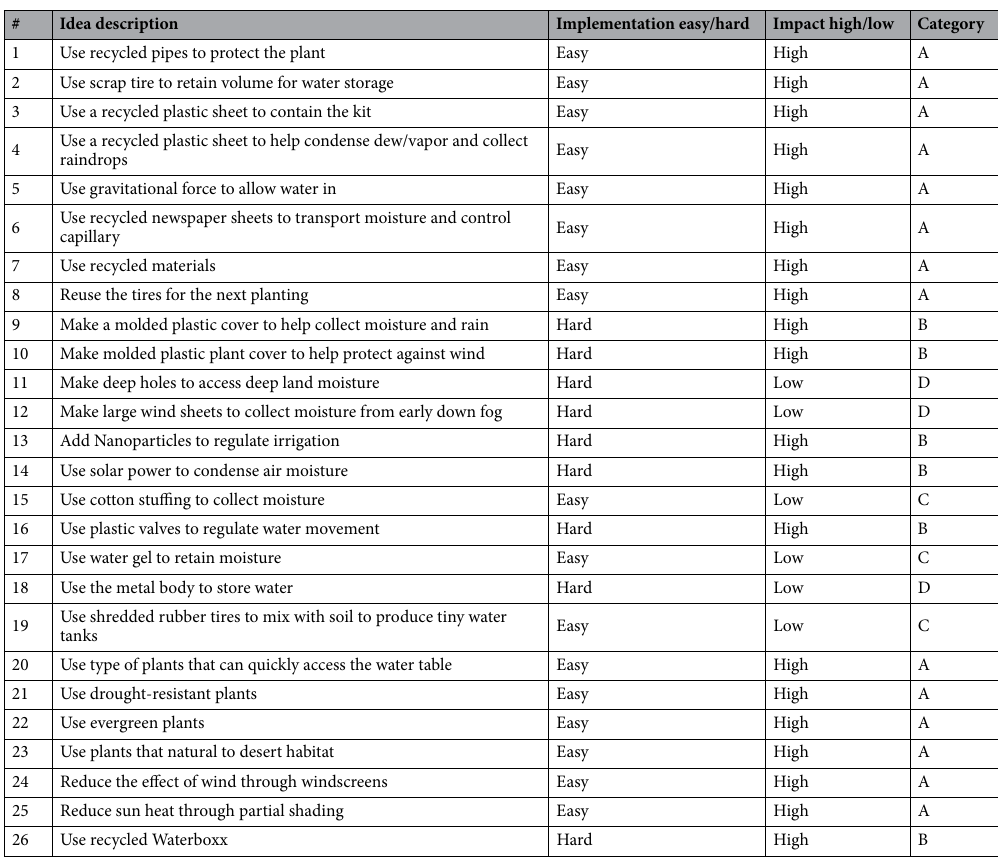
Table 3. Creative ideas were generated for the proposed designs, impact, and ABCD categorization.